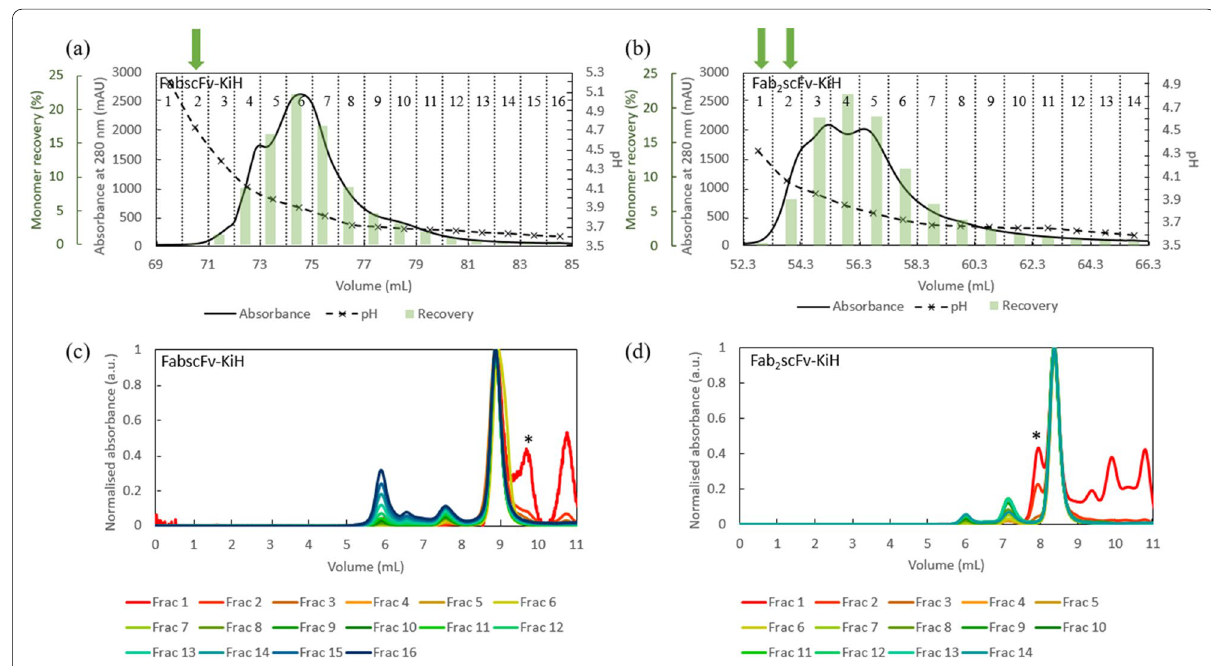
Fig. 6 AKTA chromatograms and HPLC-SEC chromatograms of elute fractions of MabSelect PrismA runs. AKTA chromatogram of the 5 CV gradient elution from pH 6.0 to pH 3.6 with a 15 CV hold at pH 3.6, with the point corresponding to pH 4.7 for FabscFv-KiH ( a ) as well as pH 4.3 and 4.1 for Fab 2 scFv-KiH ( b ) indicated with green arrows. The pH values indicated here represent the pH of each fraction measured by an external pH probe, with each fraction number indicated at the top of the chromatogram. HPLC-SEC chromatogram of FabscFv-KiH ( c ) and Fab 2 scFv-KiH ( d ) of each fraction of the eluates with absorbance values normalized to that of the monomeric peak, where each absorbance value was divided by the highest absorbance value of the monomeric peak. The likely hole–hole homodimeric mispaired products are indicated